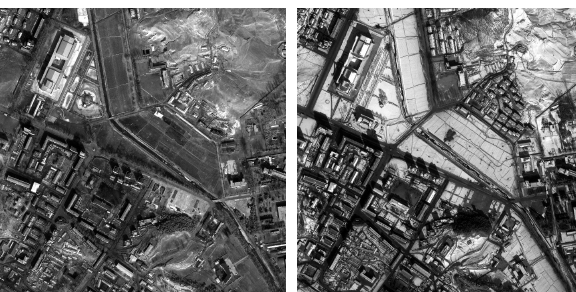
Figure 7: Ortho images of Ikonos scenes of 2006 (left) 2010 (right, covered with snow), both sections 1000 m × 1000 m